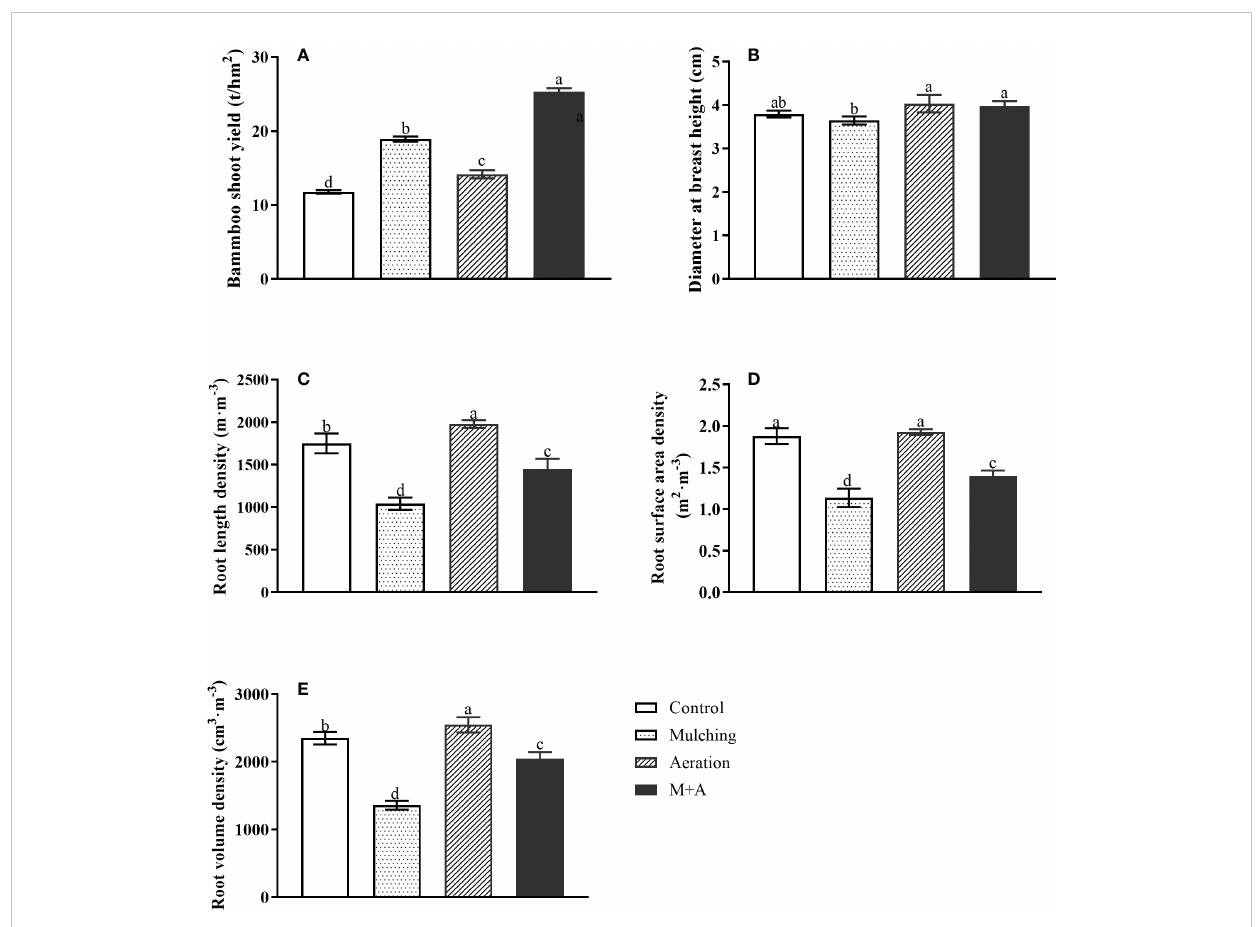
FIGURE 1 Effects of aeration on shoot production (A) , diameter at breast height (B) , root length density (C) , surface area density (D) and root volume density (E) in the bamboo forest under mulching conditions (Control, Mulching, Aeration, M + A). The vertical bars ± re fl ect the standard deviation of the mean. Different letters in the same period represent different signi fi cance ( p<